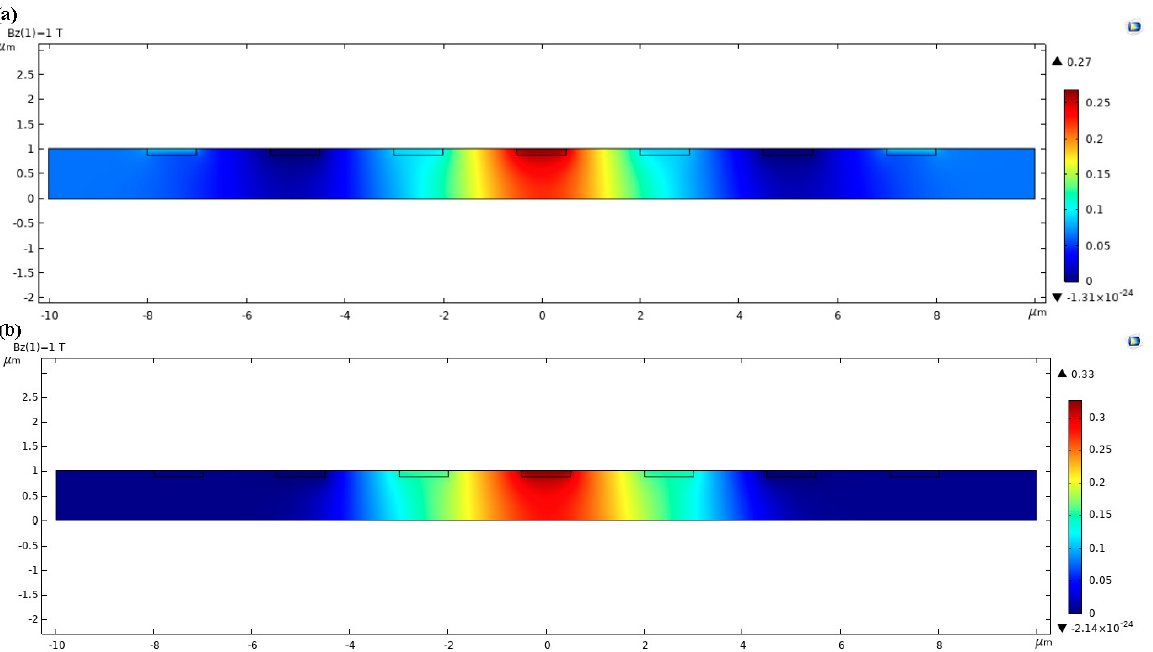
Figure 2. Cross-section ( a ) and top view ( b ) of the proposed 7CVHS. ( c ) 7CVHS in five-contact mode (5CVHS).